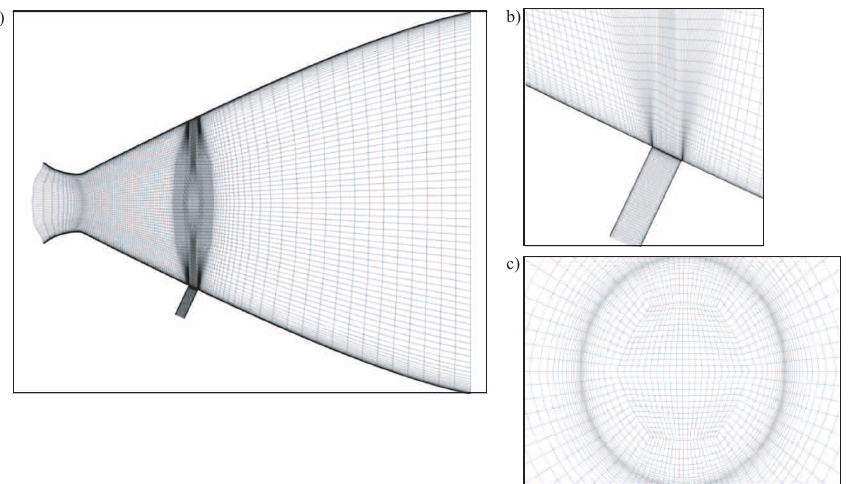
Figure 4. Computational mesh ( a ), mesh near injection port ( b ) and mesh in cross section of the injection port ( c ) with l j = 0.3, α j = 90 ◦ , d 2 / d 1 = 1, A ∗ / A a = 1.